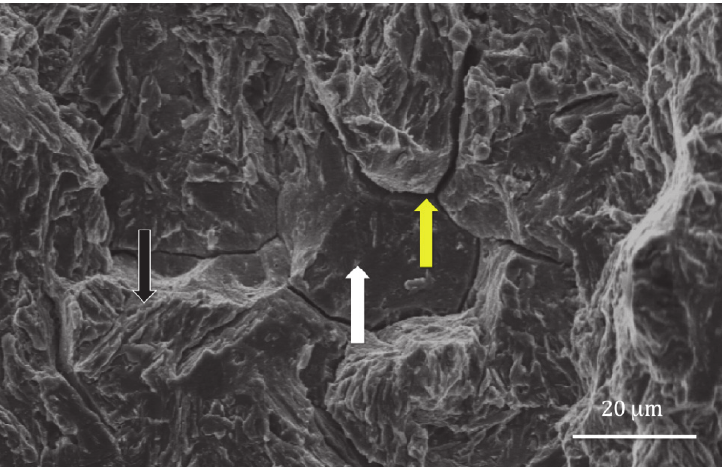
Figure 5: Fracture surface of a specimen after the toughness test. The specimen was hydrogen pre-charged before the test. Typical brittle surface is evidenced by facets (black arrow), intergranular cracks (white arrow) along grain borders and secondary cracks (yellow